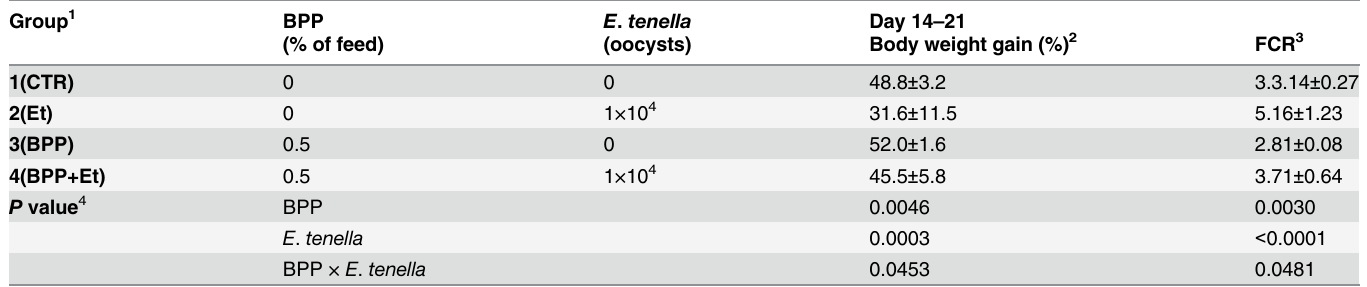
Table 1. Effects of B . pilosa on body weight of chickens before and after E . tenella